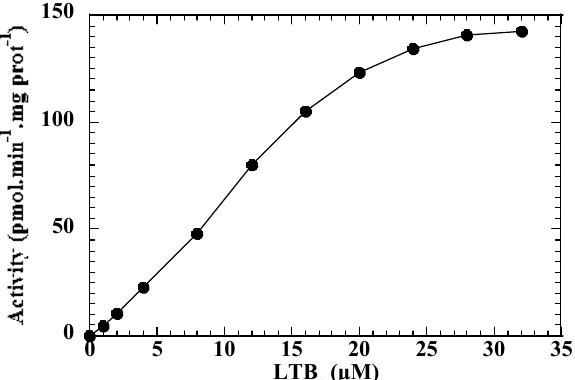
Figure 2. Dependence of ω -hydroxylase activity of yeast microsomes expressing CYP2U1 upon LTB 4 concentration. Microsomes were incubated for 15 min at 28 °C with various concentrations of LTB 4 in the presence of 1 mM NADPH, treated and analyzed by HPLC as indicated in Materials and Methods. Mean values ± S.D. from three experiments. Results from a representative experiment.